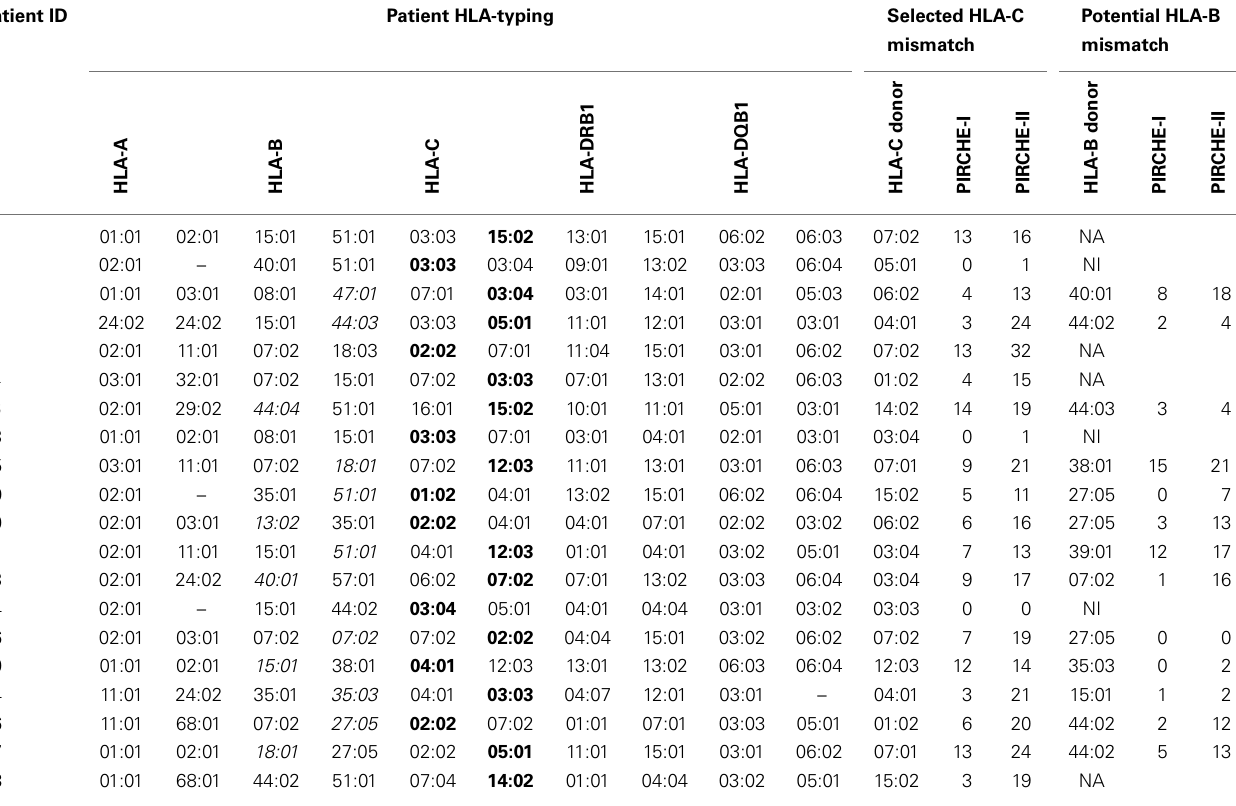
Table 2 | HLA-typing of the patient, selected HLA-C mismatch, and potential HLA-B mismatch alternative . Patient